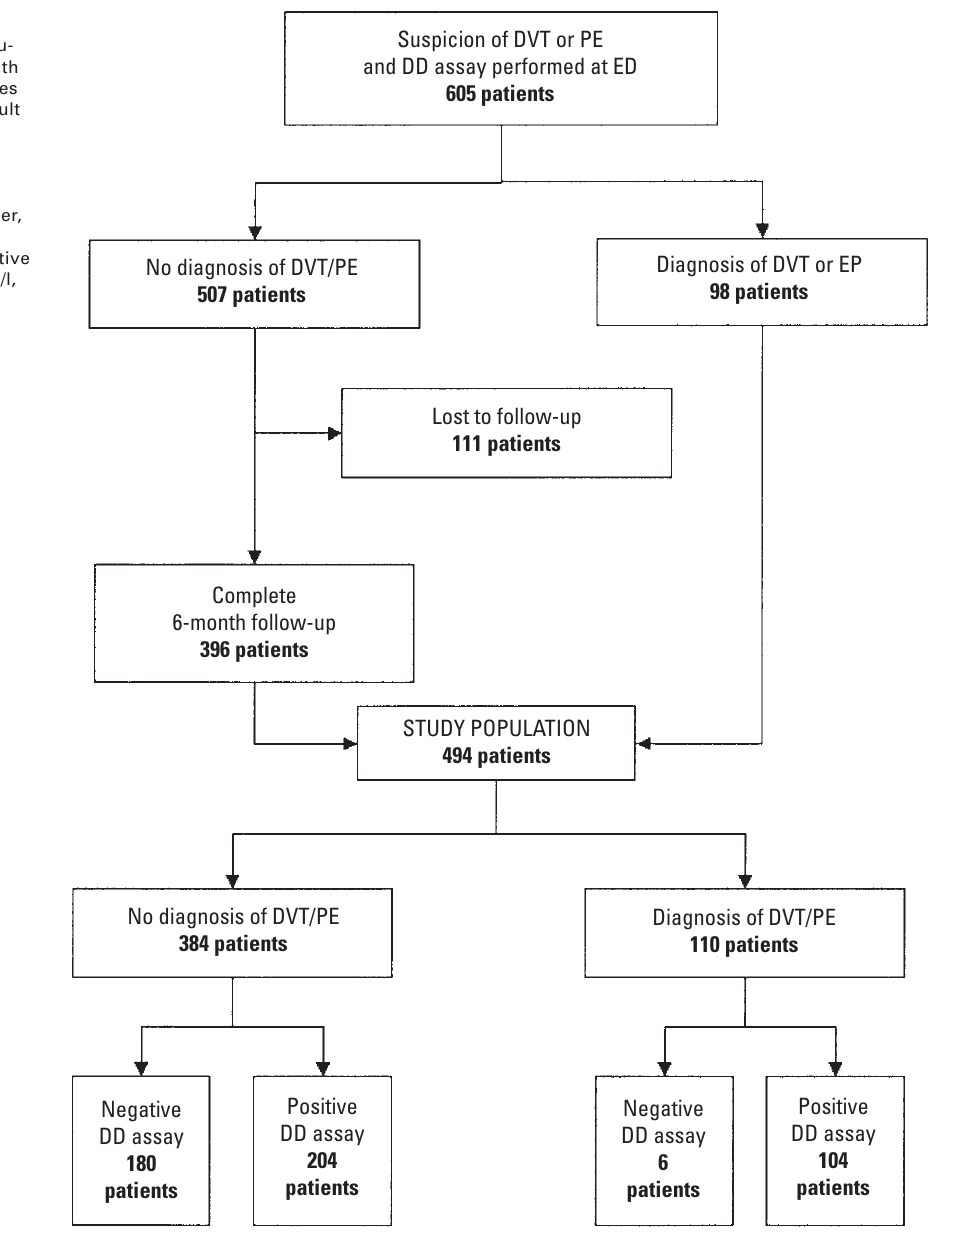
Selection and inclu- sion of patients with distribution of cases of DVT/PE and